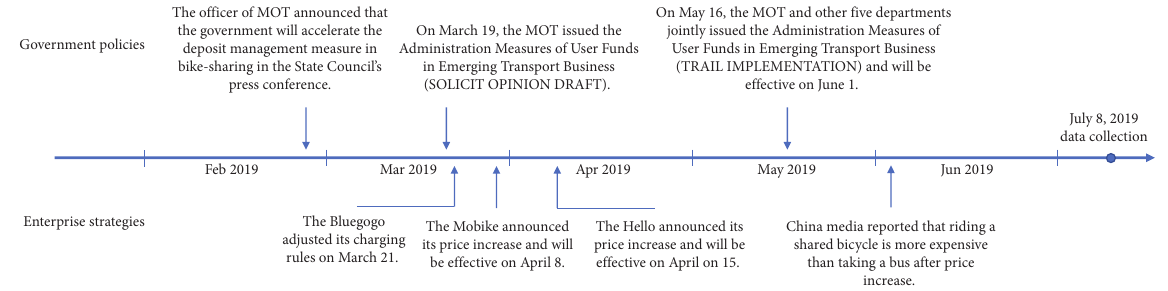
Figure 1: Overview of deposit-related policies of bike-sharing in China.